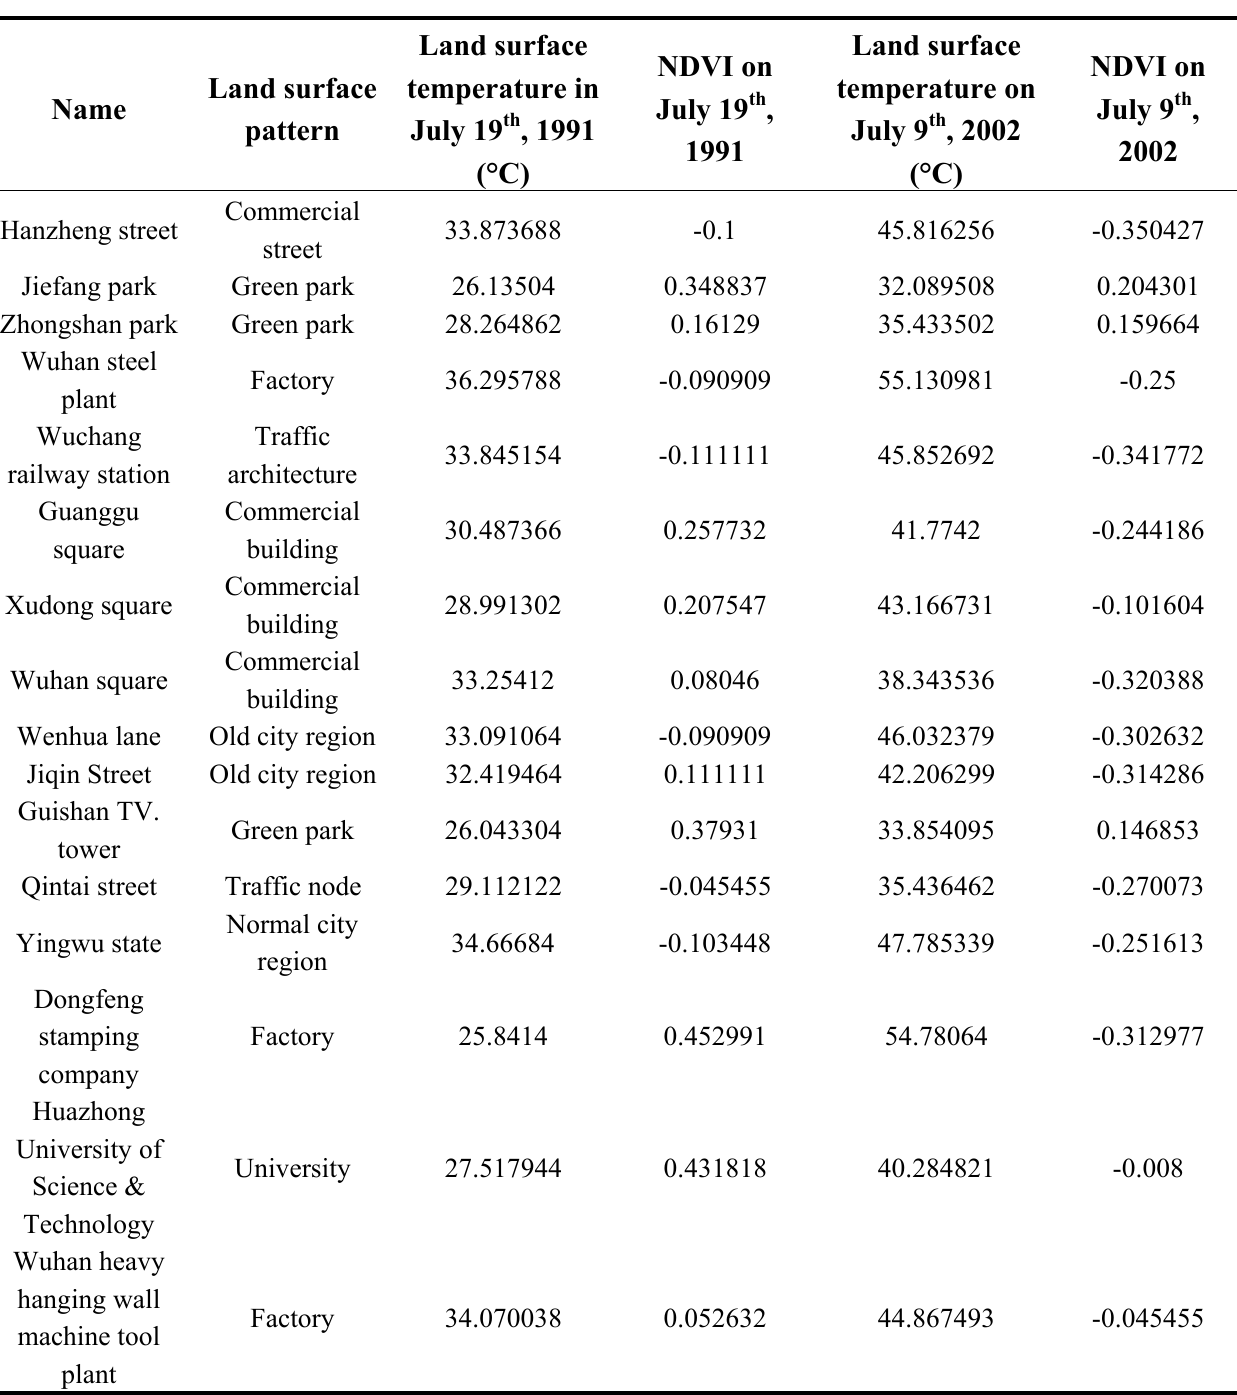
Table 3. Comparison of indices of land surface